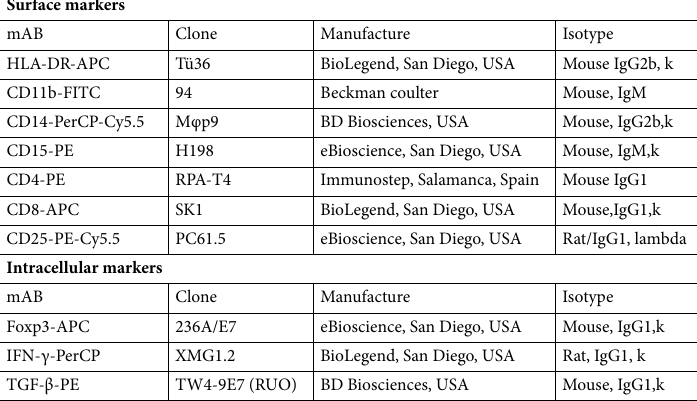
Table 1. Antibodies used in flow